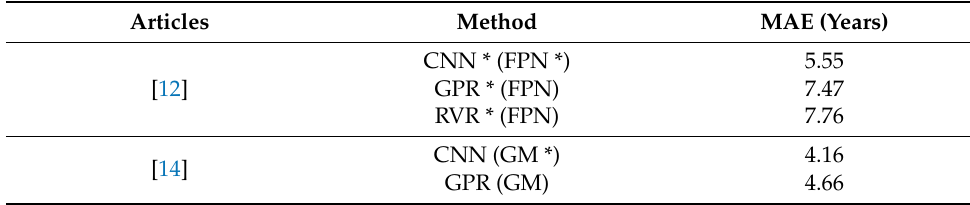
Table 1. Age prediction results reported in the